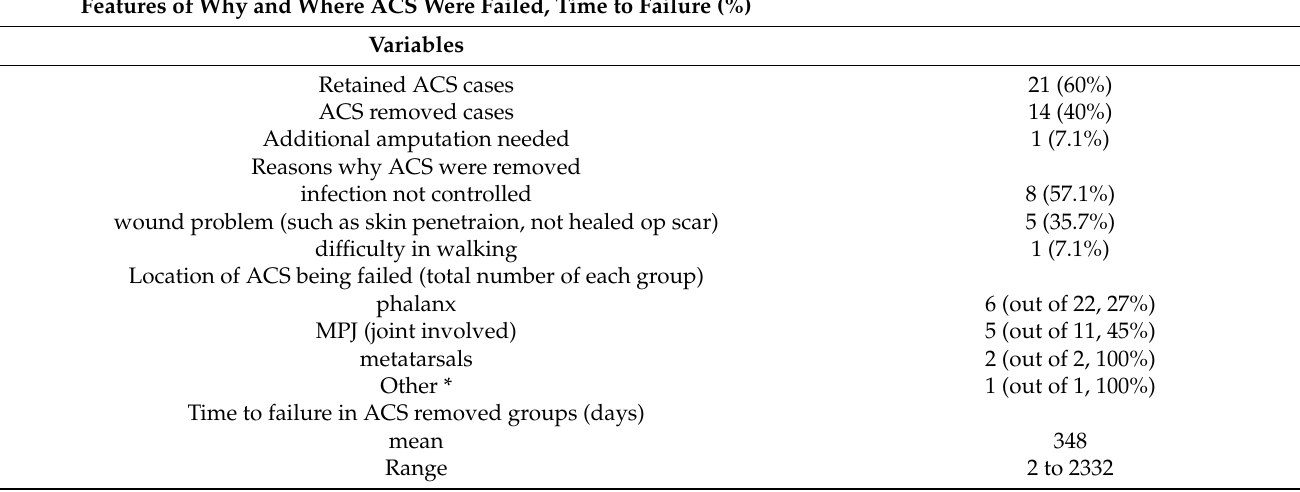
Table 4. This table shows clinical features of ACS failure group.